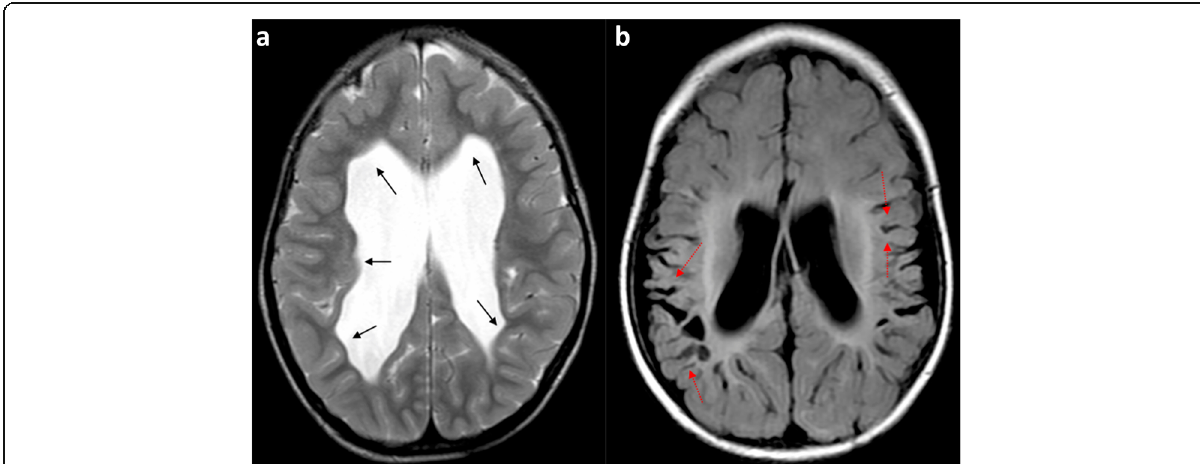
Fig. 18 a , b Comparison of ( a ) Axial T2-weighted image showing periventricular leukomalacia (PVL) with predominantly periventricular white matter volume loss in a 6-year-old boy who sustained a global hypoxic-ischaemic injury as a premature neonate, compared with ( b ) axial FLAIR image showing predominantly subcortical white matter loss in a 1-year-old boy who sustained a severe partial-prolonged hypoxic-ischaemic injury at term gestation. In the patient born prematurely with PVL ( a ), there is such severe periventricular white matter volume loss that the cortical mantle at the sulcal depths abuts the ventricular ependymal edges, causing a ‘ wavy ’ ventricular margin (black arrows). In addition, the width of the sulci is of equal size at their depth as at their surface, with sulci and gyral surfaces remaining parallel. The patient born at term with partial-prolonged hypoxic-ischaemic injury ( b ) demonstrates preservation of some of the periventricular white matter substance (even though of abnormally high signal) and regular ventricular margins as the cortical mantle at the sulcal depth is separated from the ventricular ependymal edge. There is also ulegyria at the peri-Sylvian regions bilaterally (red dotted arrows)